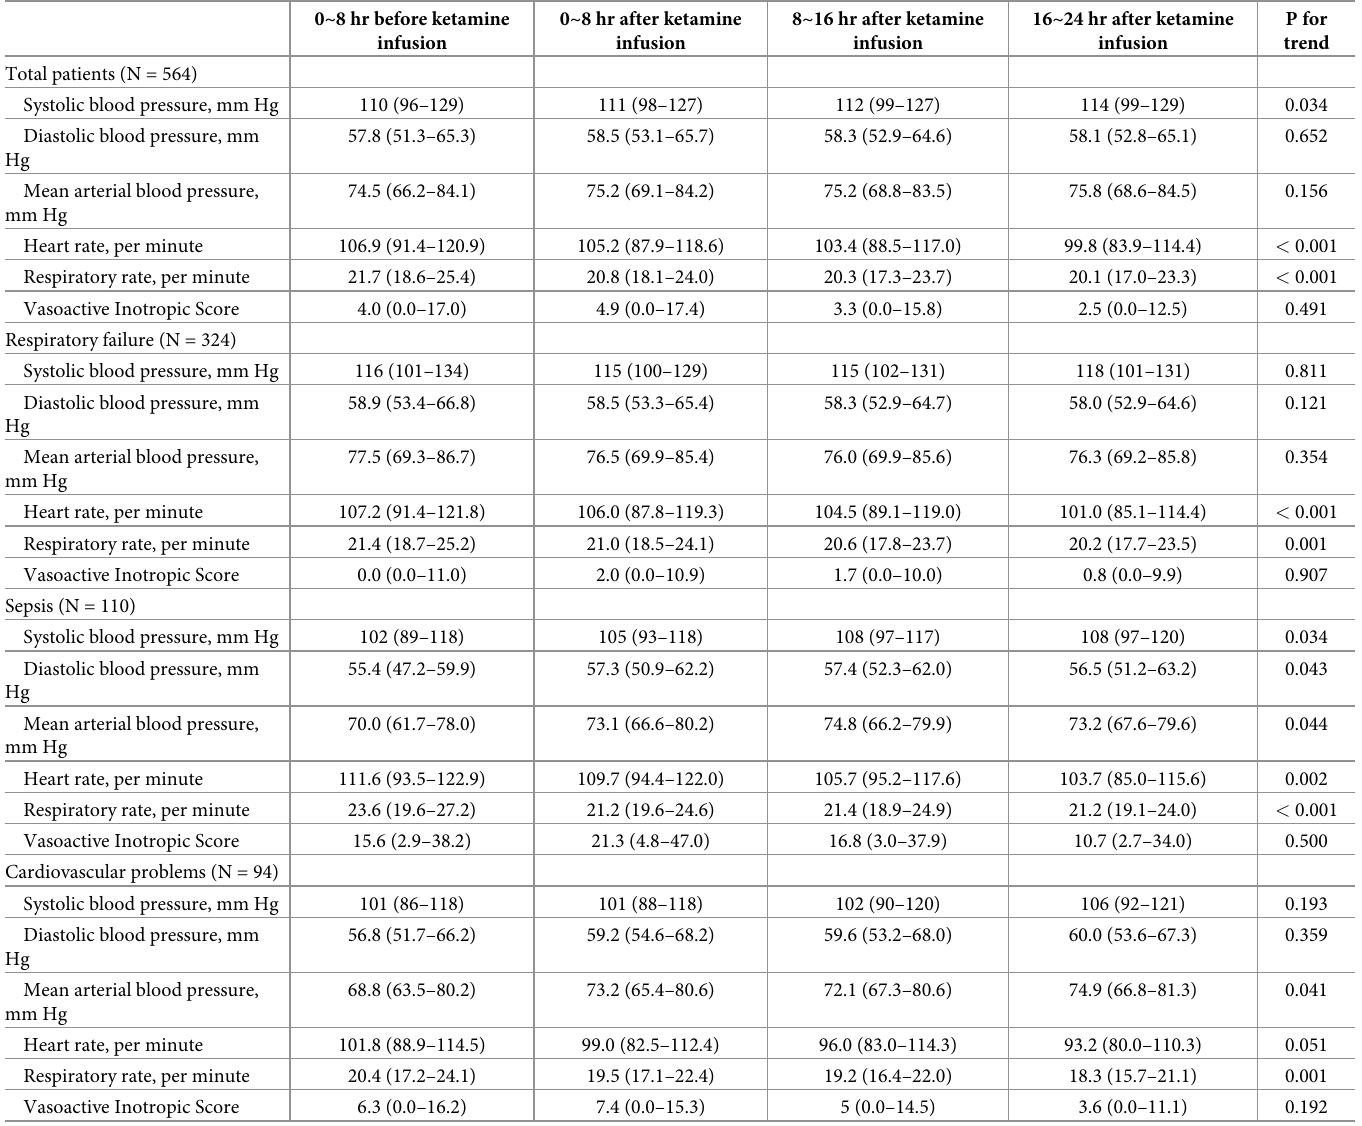
Table 3. Hemodynamic trends during continuous ketamine infusion according to the diagnosis at ICU admission. 0~8 hr before ketamine